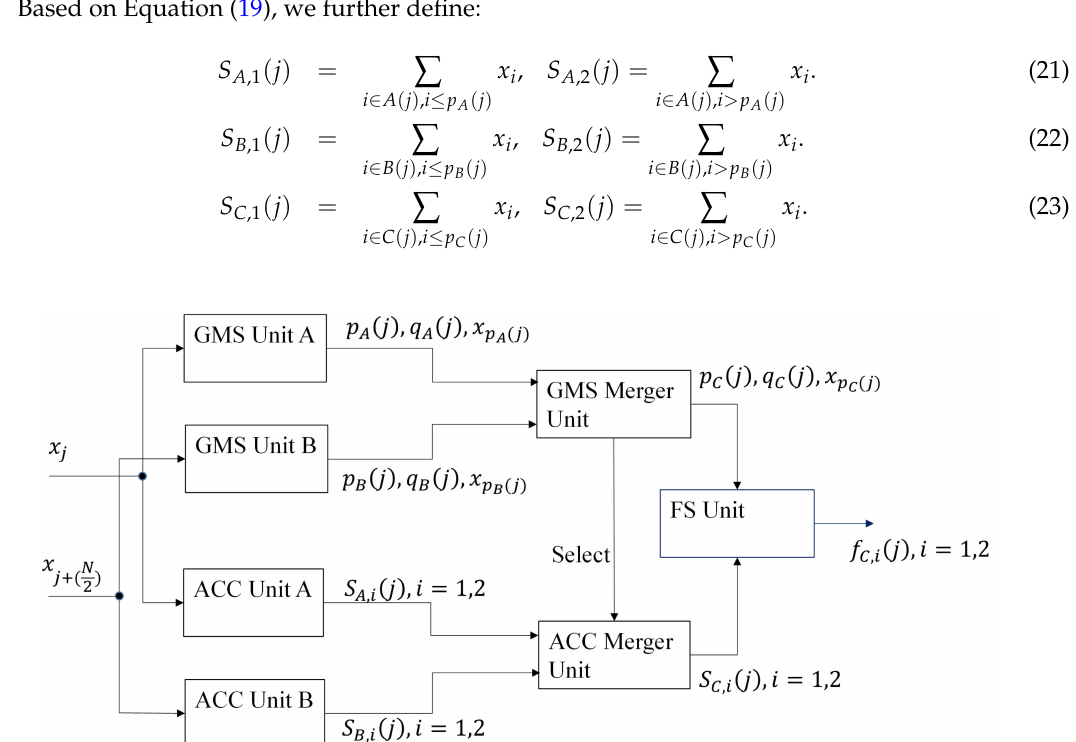
Figure 9. The proposed architecture for the concurrent operations with K =